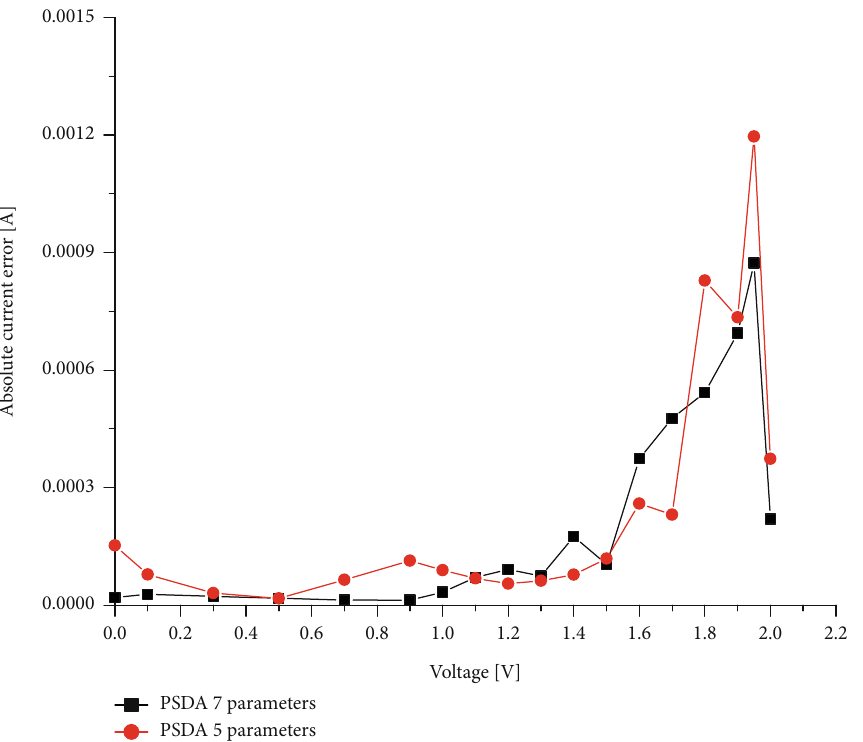
Figure 5: Comparison between the two-diode and one-diode model for RTC.